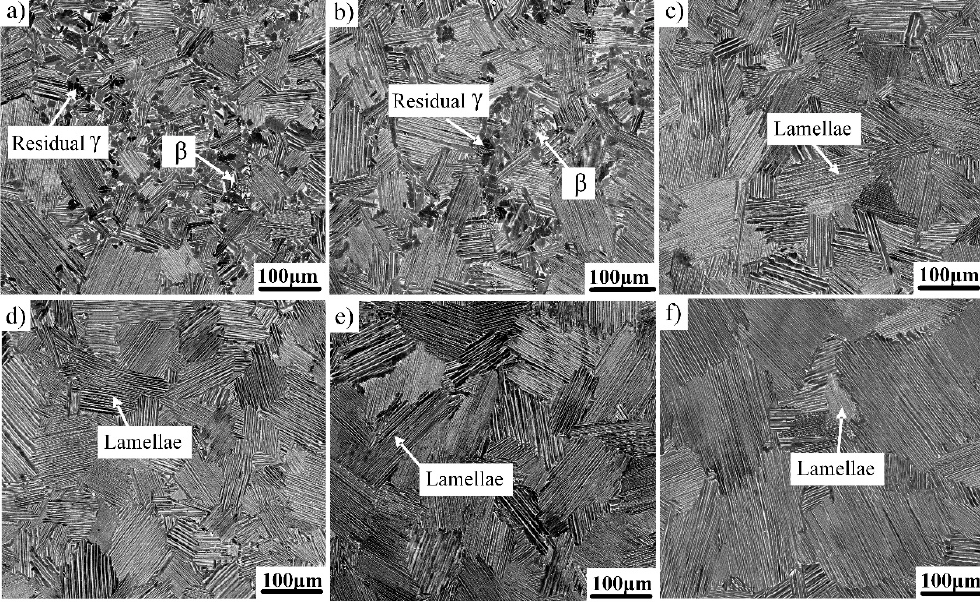
Figure 2. Lamellar microstructures of the as-forged Ti–43Al–2Cr–2Mn–0.2Y alloy in different heat treatment conditions: ( a ) 1300 °C/10 min, ( b ) 1310 °C/10 min, ( c ) 1320 °C/10 min, ( d ) 1340 °C/10 min, ( e ) 1360 °C/10 min, and ( f ) 1320 °C/2 h.